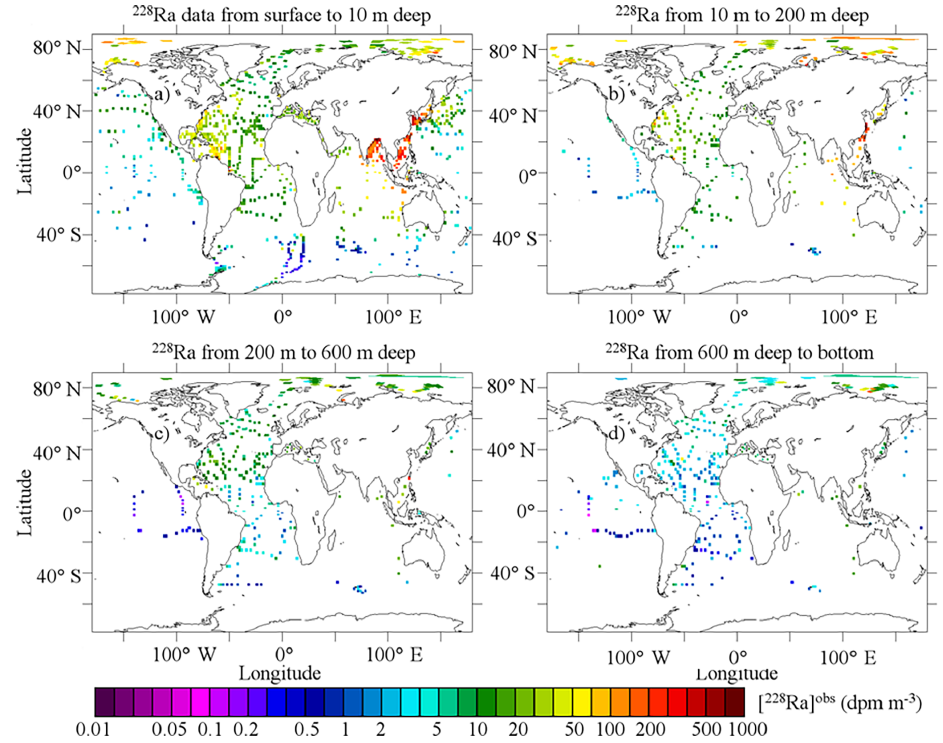
Figure 1. Observed concentrations of 228 Ra in the global ocean, averaged when available on the ORCA2 cells used for inversion. Data plotted on subfigures (b, c, d) are also vertically averaged in order to take all layers into